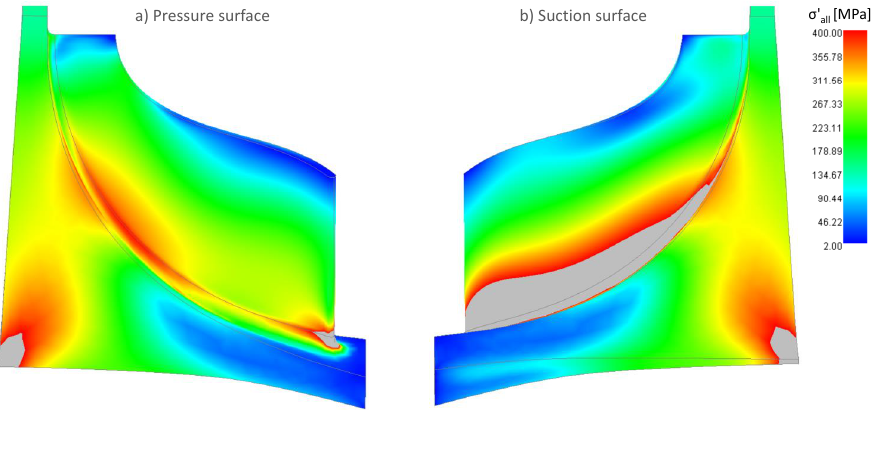
Figure 14. von-Mises stress distribution on rotor blade surfaces: ( a ) Pressure surface, ( b ) Suction